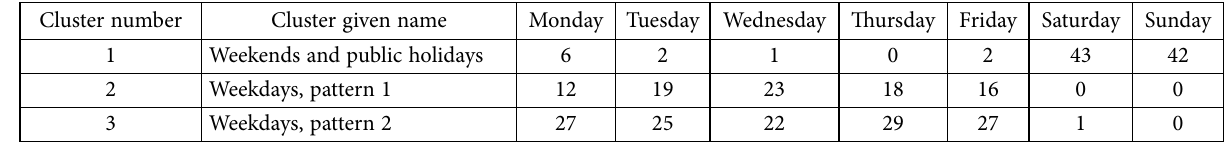
Table 4. Distribution of weekdays between the clusters